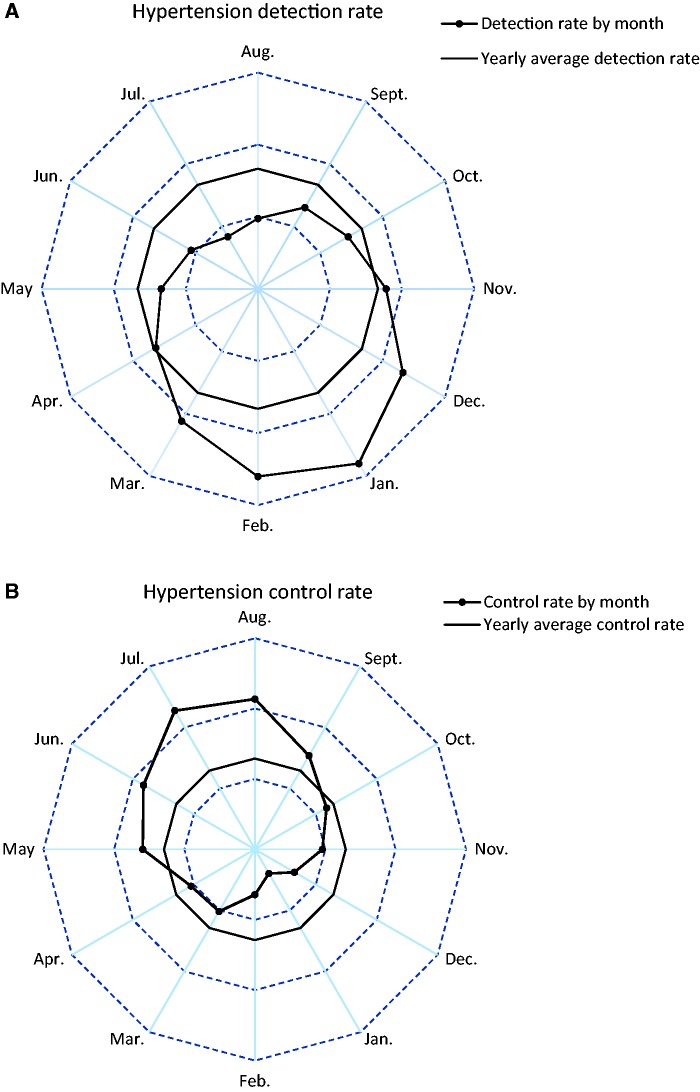
Monthly and yearly averages of hypertension detection and control rates. Rates were adjusted for age, sex and education. Solid lines with dots represent mean hypertension detection/control rates in every month; solid lines without dots represent yearly average hypertension detection/control rates; dashed lines from centre to periphery represent 20%, 40% and 60%, respectively.